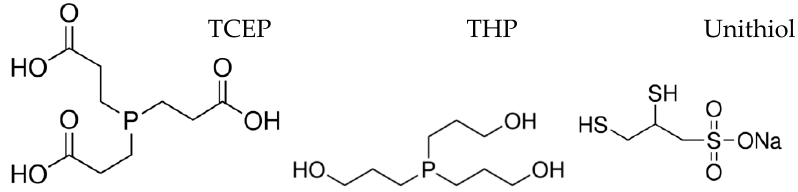
Figure 3. Chemical structure of tris(2-carboxyethyl)phosphine (TCEP), tris-hydroxypropyl-phosphine (THP) and unithiol.